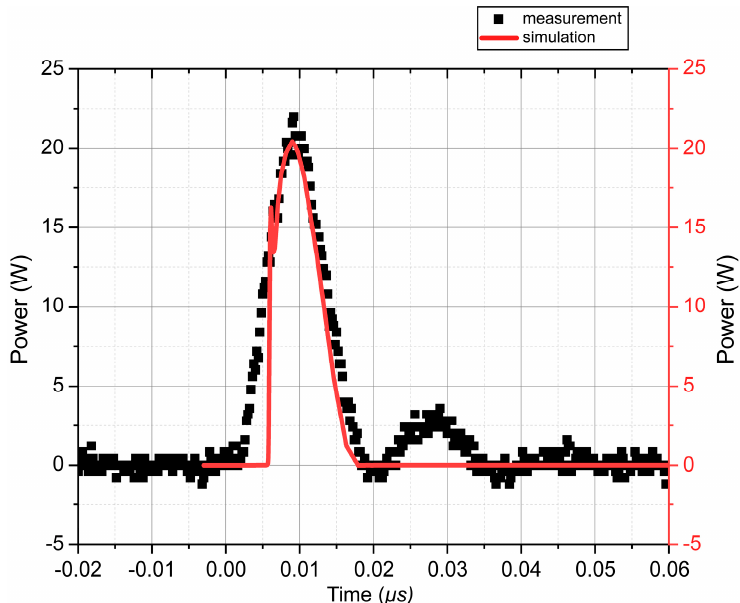
Figure 15. Simulated and measured optical-pulse waveforms of the laser − emission module.